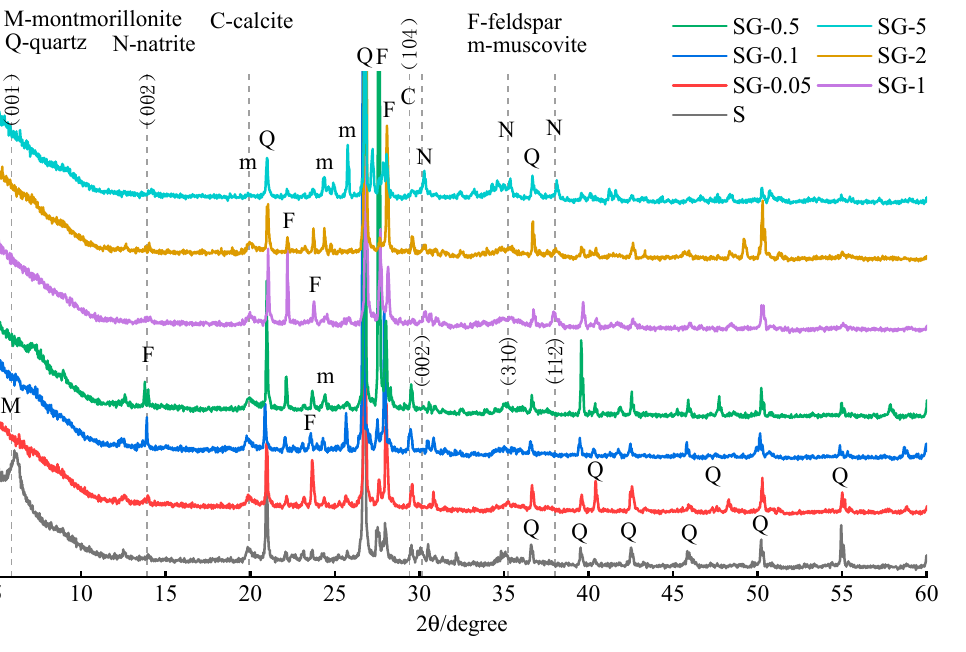
Figure 6. XRD of the residues after leaching. (SG-#: the mechanochemically activated WPS was immersed in a solution of # M NaOH for 28 days, the value of # was 0.05, 0.1, 0.5, 1.0, 2.0, and 5.0, respectively; S: WPS sample immersed in distilled water for 28 days).